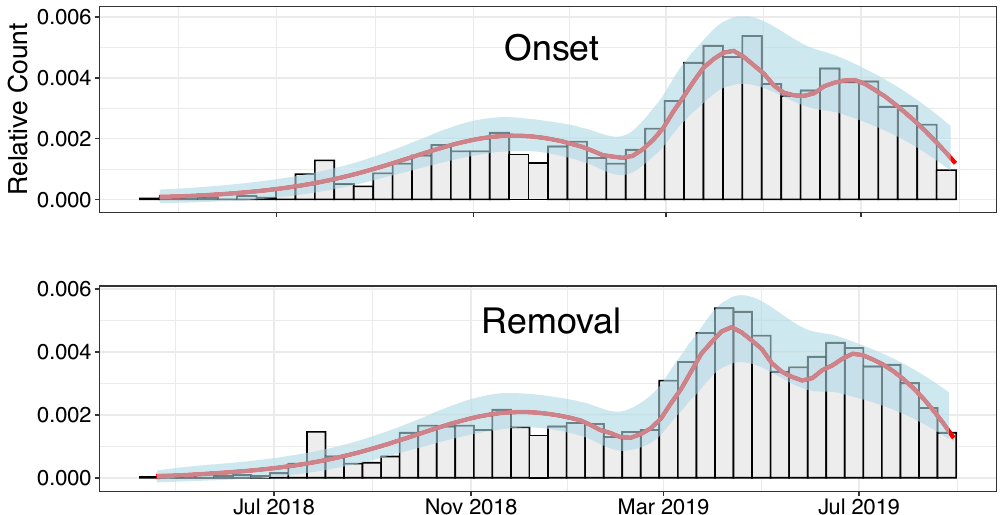
Figure 3. Model fit. Comparison of the statistical model fit (red curve) with the observed daily incidence (onset) and removal relative counts for all 3 waves of the epidemic combined. The shaded region indicates the 95% credibility bounds based on the posterior distributions of the model parameters estimated separately for each wave with values summarized in Table